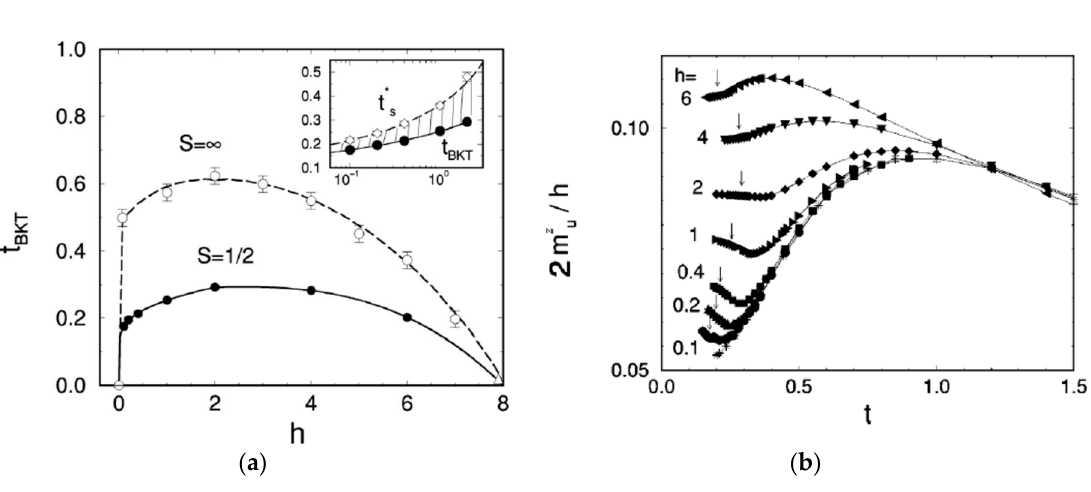
Figure 11. ( a ) Magnetic phase diagram of the S = 1/2 HAF on the square lattice (full symbols) in reduced coordinates t BKT = k B T BKT / J and h = g µ B B /( SJ ). Open symbols refer to the classical limit of the model. Inset: t BKT vs. h for weak fields, t ∗ s represents a crossover temperature from the isotropic to XY behavior. Shaded area marks the region of disordered XY behavior. (Reproduced with permission from reference [106]); ( b ) Field-induced uniform magnetization vs reduced temperature for different field values. The stars represent the zero-field uniform susceptibility of the S = 1/2 HAF on the square lattice. The arrows indicate the onset of BKT transition. (Reproduced with permission from reference